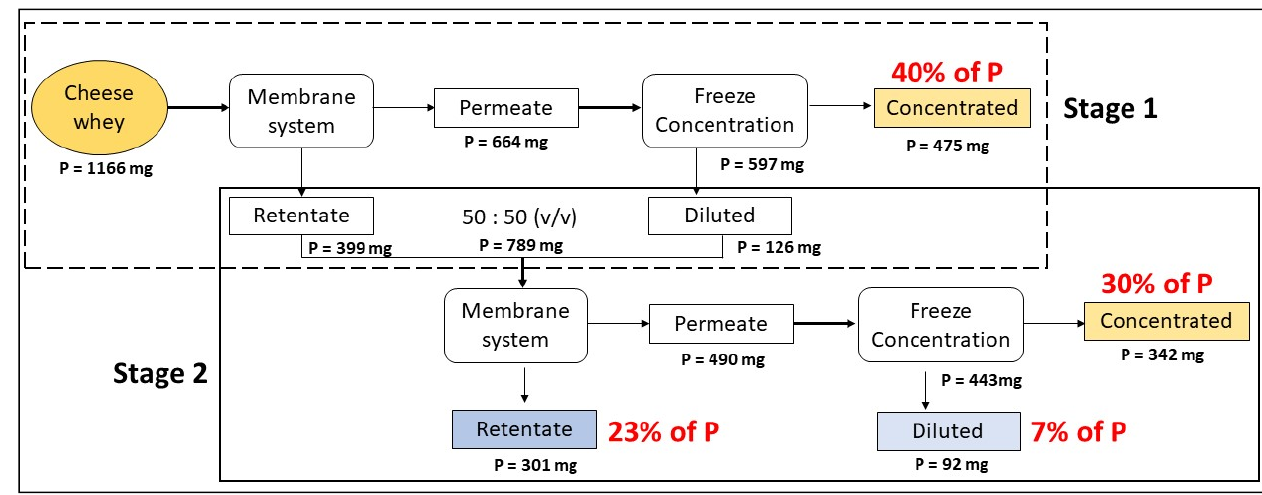
Figure 6. Phosphorus recovery percentage obtained during stages one and two of membrane filtration system coupled with freeze concentration .